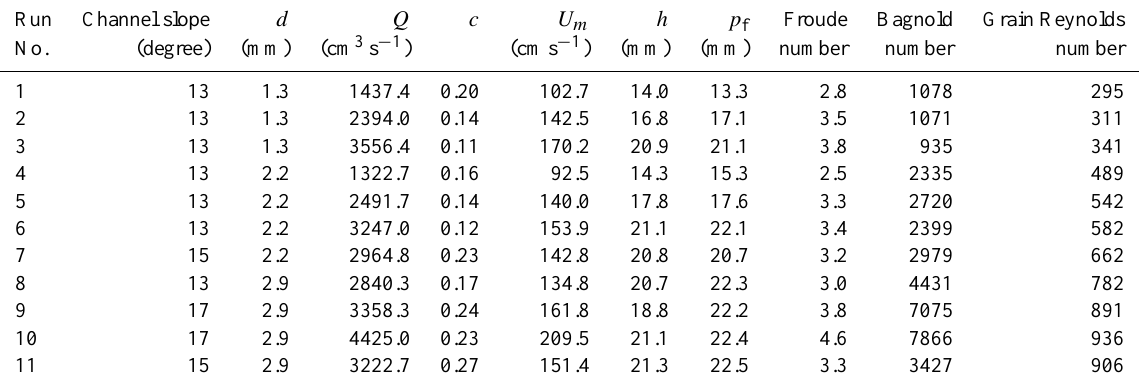
Table 2. Summary of interstitial water pressure measurement results. Run Channel slope